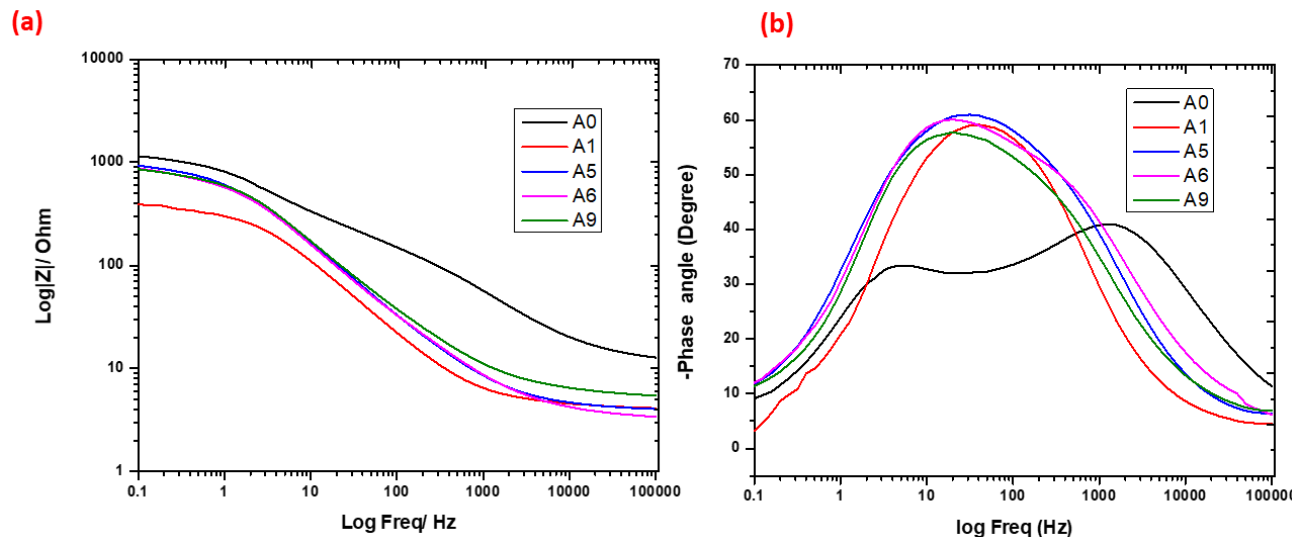
Figure 6. ( a ) Bode profiles, ( b ) Bode phase profiles of samples in 3.5% NaCl for 24 h.